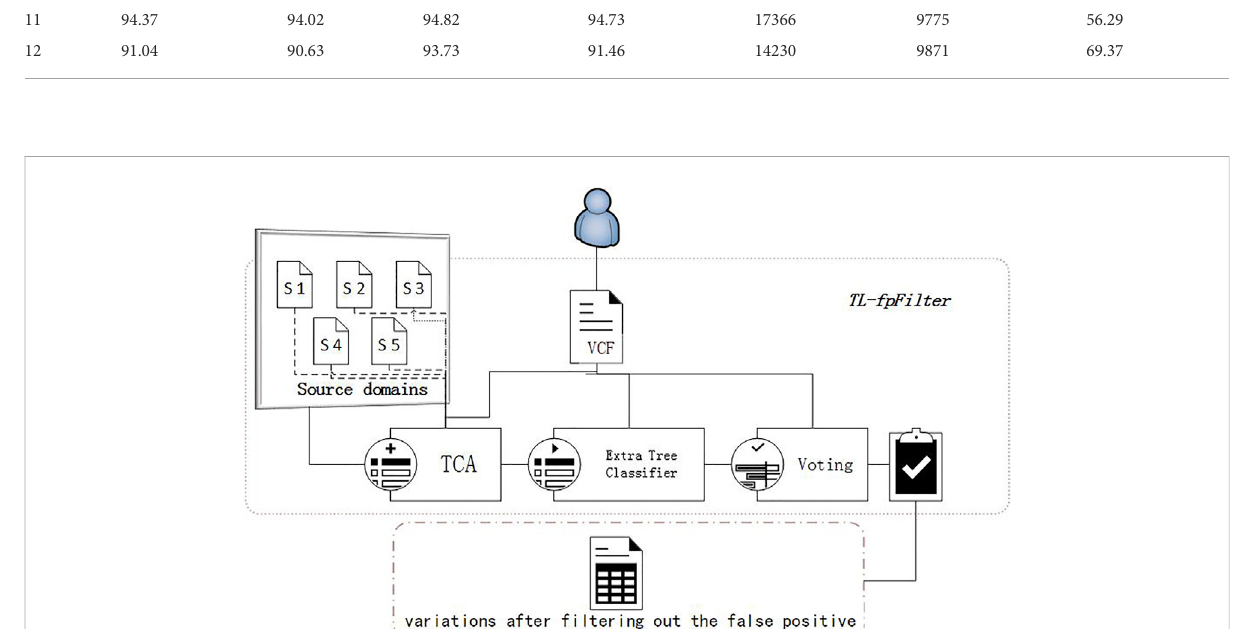
FIGURE 4 The fl ow diagram of the proposed